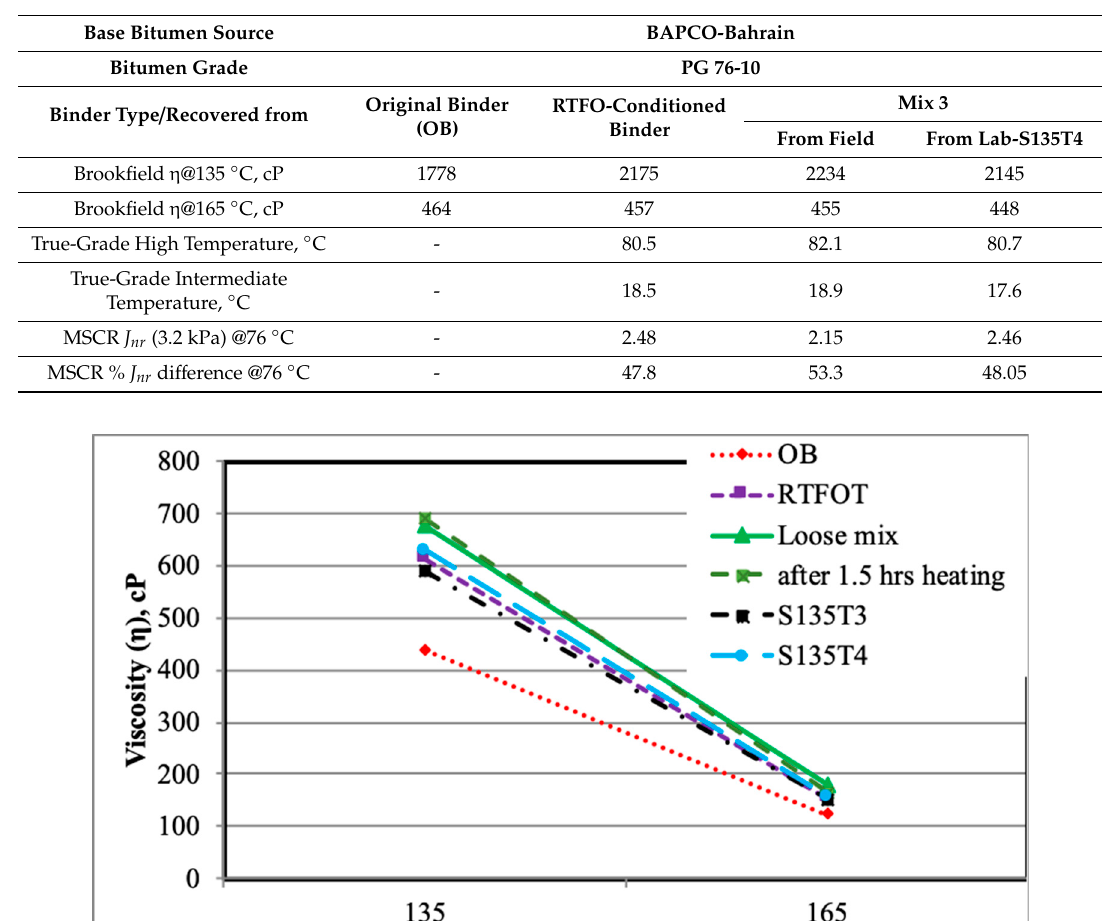
Table 7. Summary of binder test results for modified mixture (mixture 3).